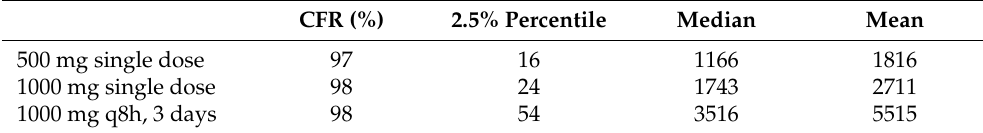
Figure 5. Relationship between AUC urine,24 /MIC and MIC for fosfomycin. Table 4. AUC urine,24 /MIC distribution (mean, median, and 2.5% percentile) and CFR